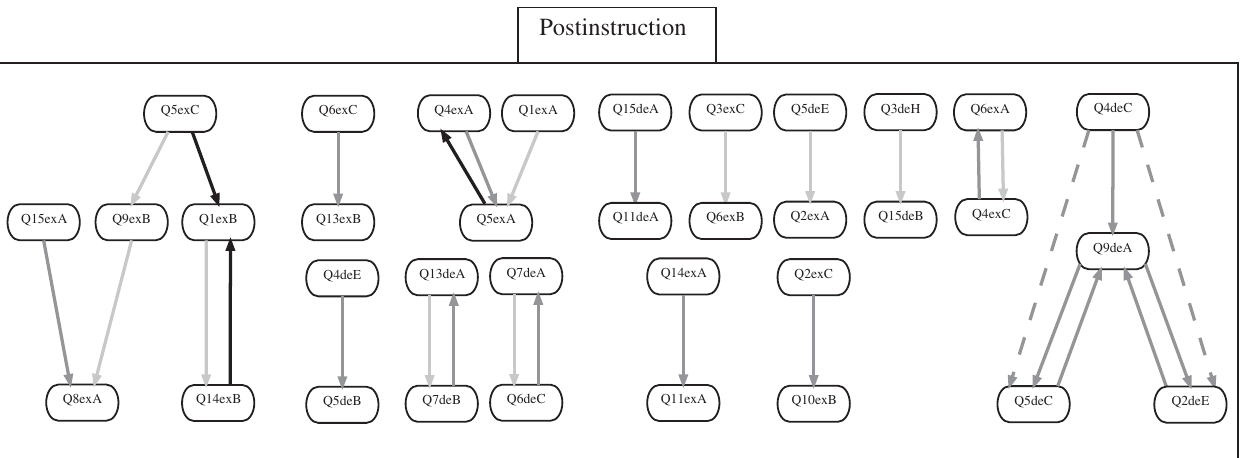
FIG. 6. Implicative graph for the answers to the questionnaire in postinstruction administration. As in Fig. 4, black arrows indicate an incidence of implication greater than the 93% between two connected strategies. The gray color is used to indicate implications between 90% and 93%; light gray arrows indicate an implication between 87% and 90%. Dashed lines show transitive